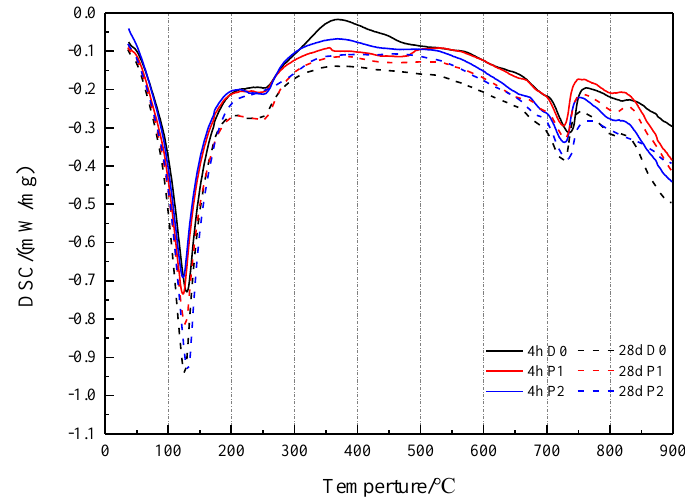
Figure 11. DSC curves of composite cement in N 2 atmosphere.